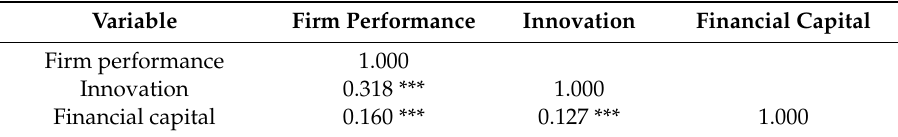
Table 3. Correlation